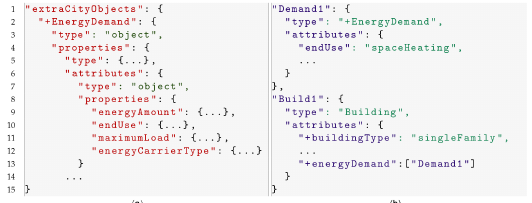
Figure 7. New non-CityObject (a) defined under “extraCityObjects” in the Extension schema, (b) used in a CityJSON file with a relationship to a Building object.